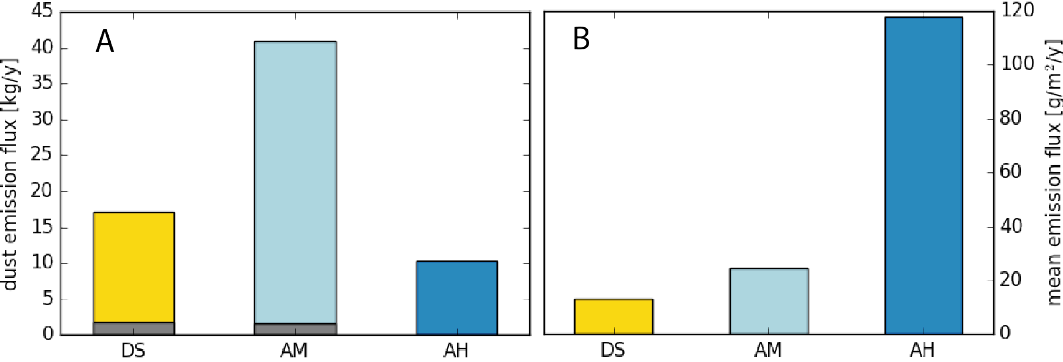
Figure 9. Total dust emission flux for each surface type (DS, Dune/Sand sheet; AM, Medium emitting alluvial; AH, High emitting alluvial) and total emission flux derived from control run (grey) for the same cells ( A ); and spatial mean of total emission flux for each cell and surface type ( B